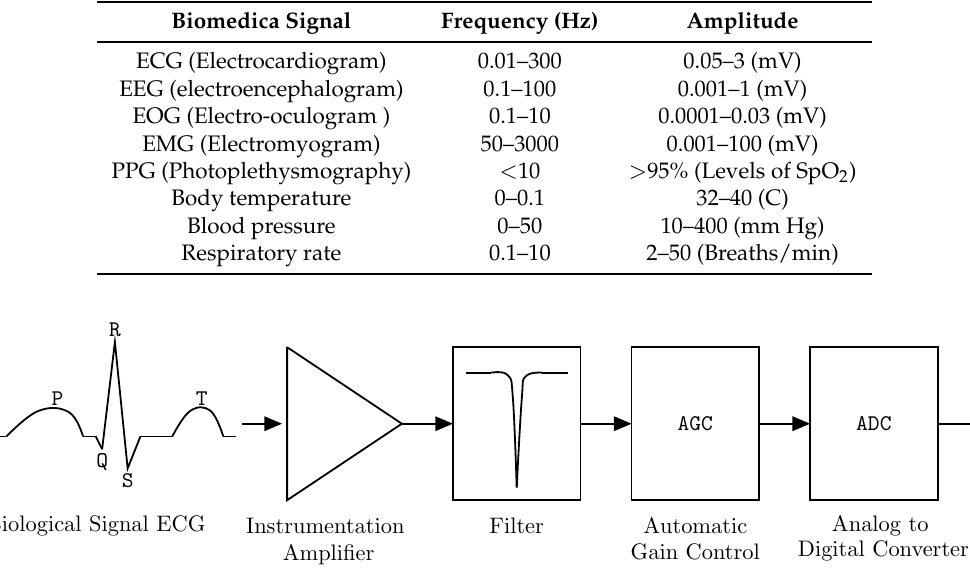
Figure 1. Basic diagram for a biomedical